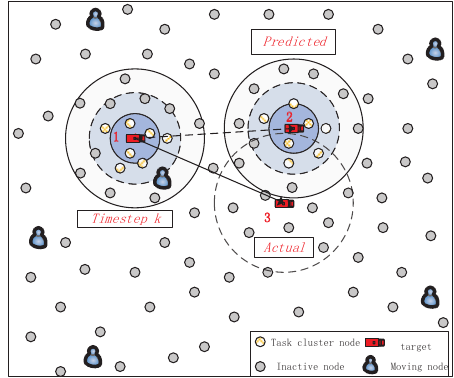
Figure 3. An example of selecting the next cluster nodes. At timestep k , the CH will predict the target position at timestep k + 1 according to the current estimations of target state. Then, the SNs close to